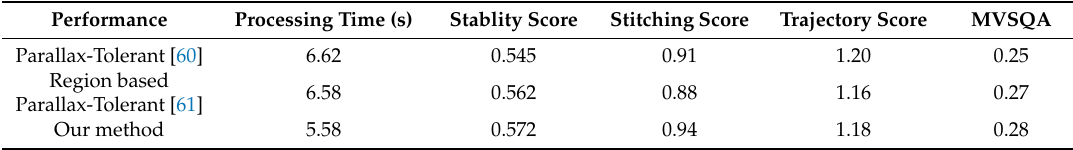
Table 3. Comparison of results with related